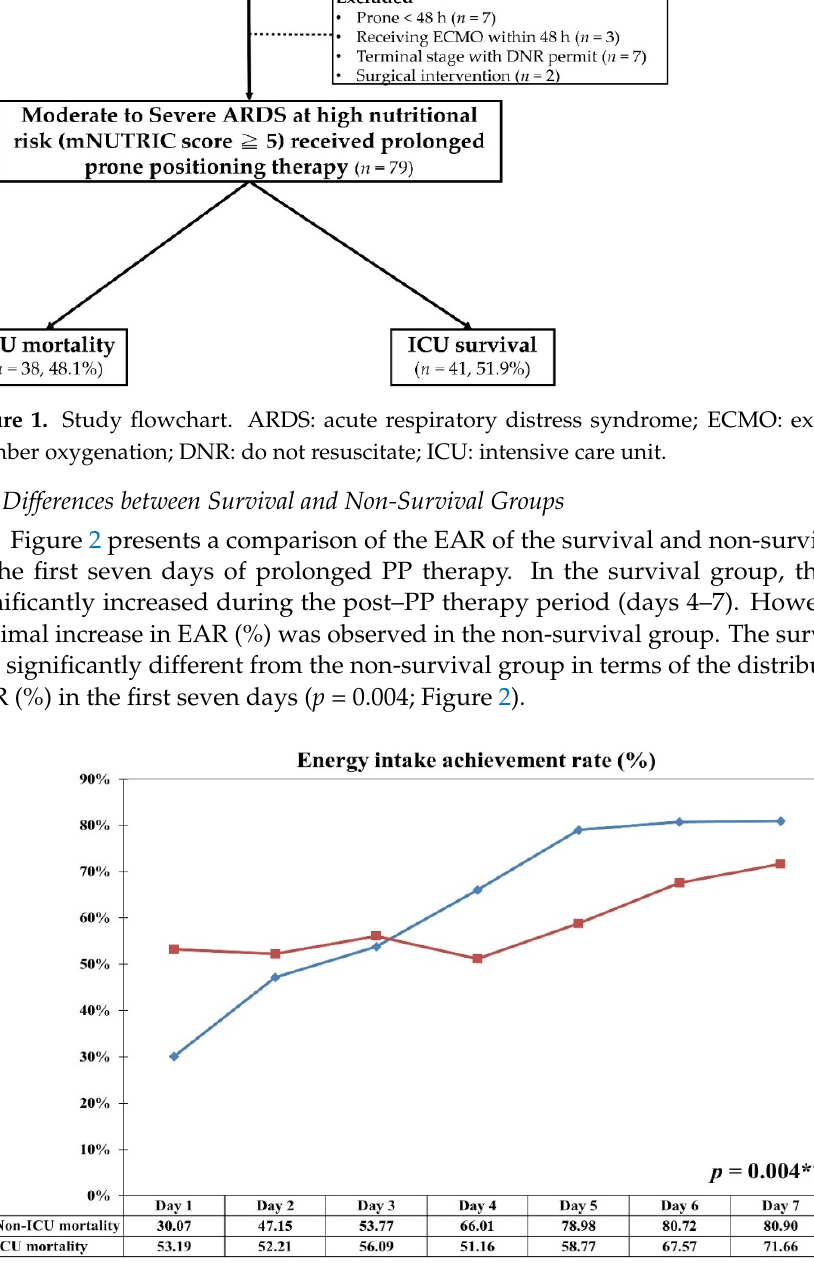
Figure 2. Comparison of energy achievement rate (EAR) during the first week of intensive care unit (ICU) admission between the survival and non-survival groups. ** p < (ICU) admission between the survival and non-survival groups. ** p < 0.01